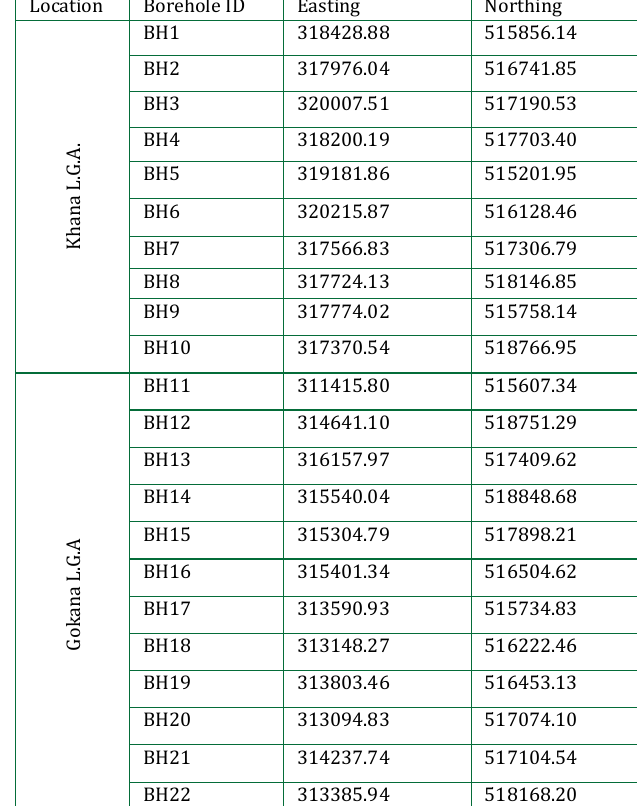
Map of Khana and Gokana Areas showing study